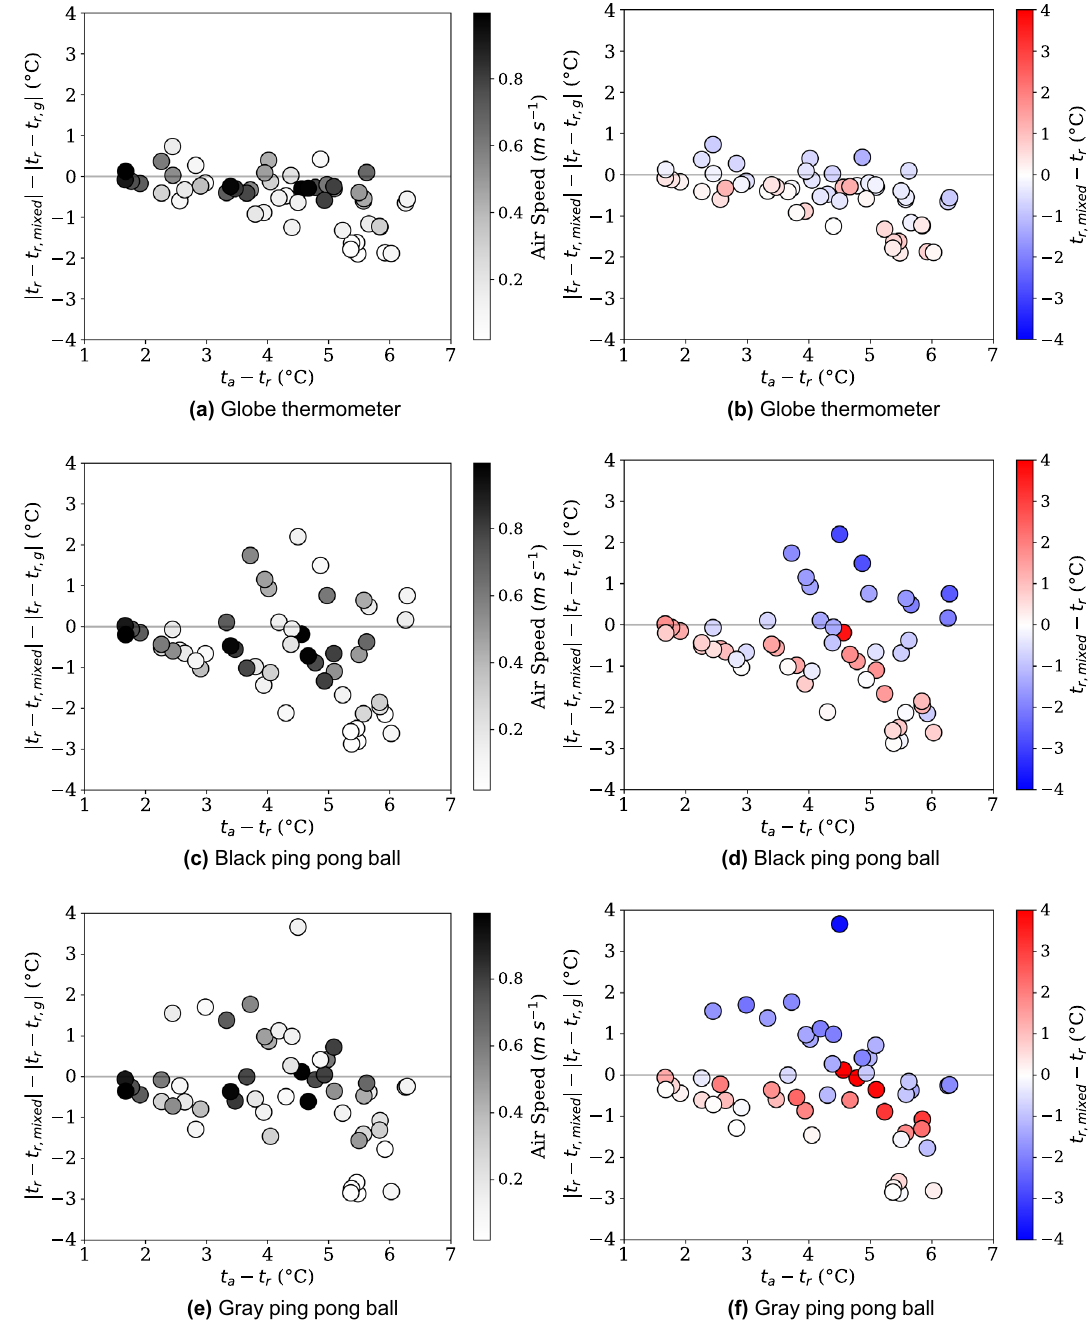
Figure 10. A relative comparison between the standard correction factors and the proposed mixed correction factor is shown for each globe thermometer. Gradients correspond to air speed (left and grayscale) and absolute error (right and blue-to-red